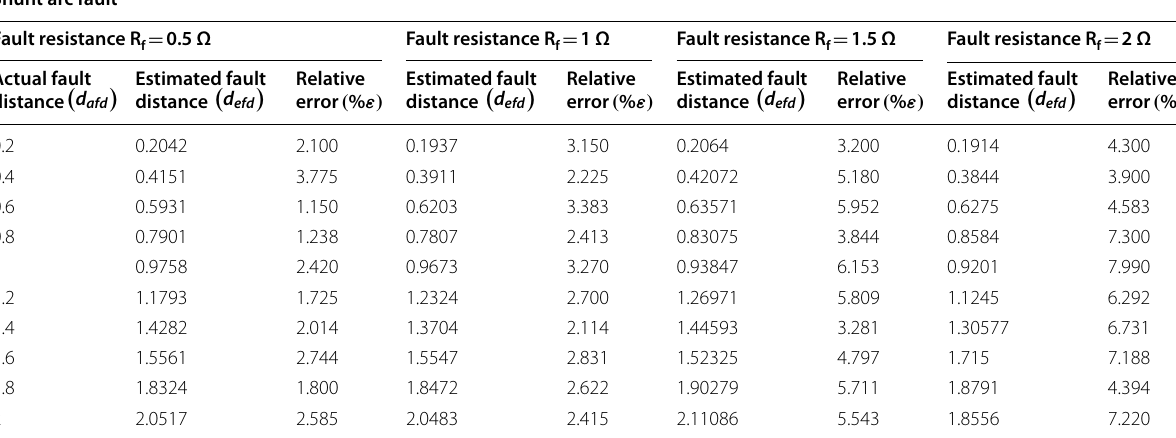
Table 13 Shunt arc fault distance estimation using FF-RLS algorithm Shunt arc fault Fault resistance R f 0.5 Ω =